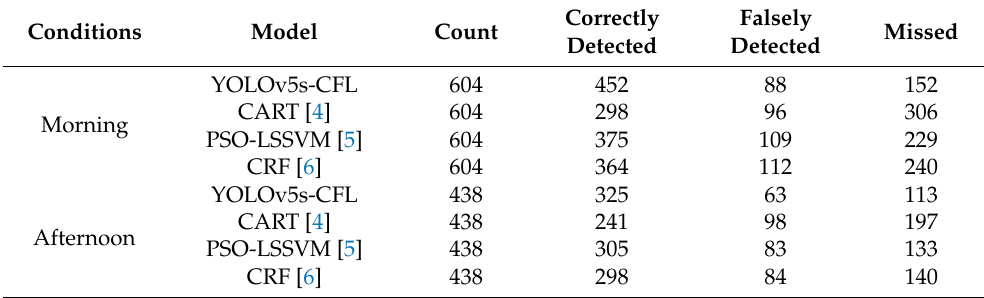
Table 3. The detection results of our methods and traditional computer vision